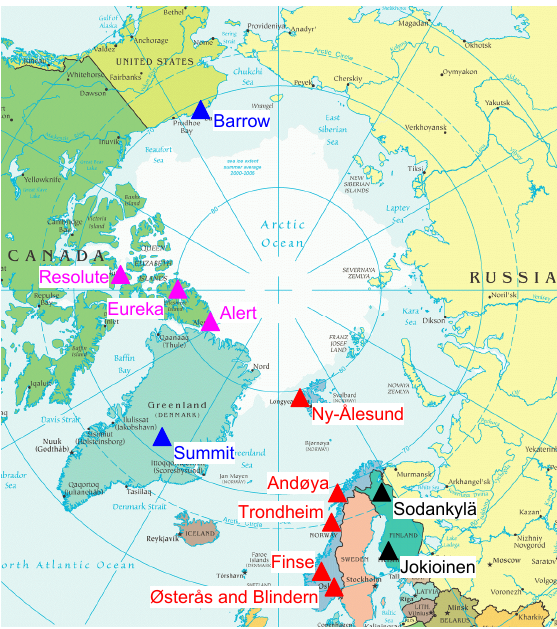
Figure 1. Locations of instruments operated by Environment Canada (pink), Biospherical Instruments (blue), the Norwegian Ra- diation Protection Authority and the Norwegian Institute of Air Re- search (red), and the Finnish Meteorological Institute (black).